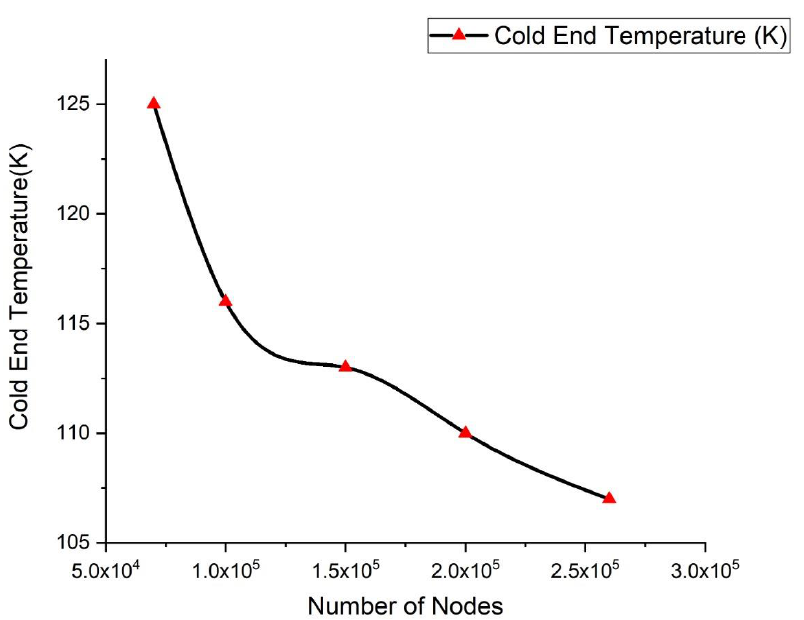
Figure 2. Grid independence test of DIPTR.